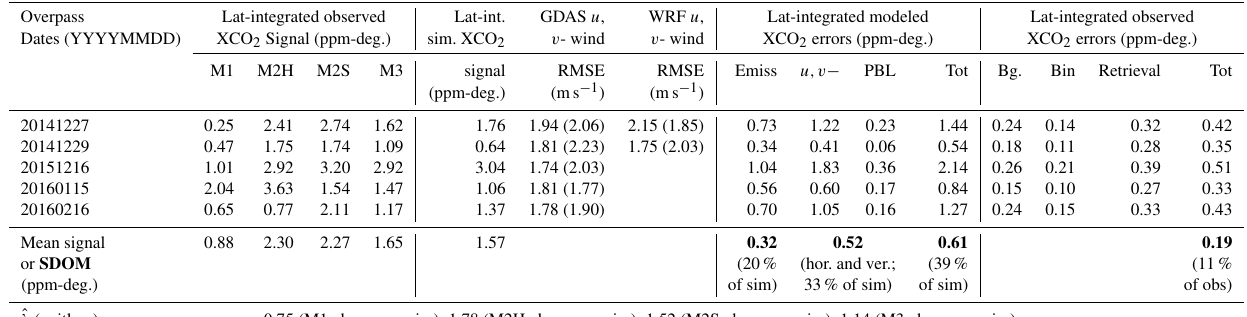
Table 1. Results of signal and error calculations for the five overpasses examined, including latitude-integrated observed versus modeled XCO 2 enhancements and errors (ppm-degree of latitude), regional wind RMSE (ms − 1 ), and the standard deviation of the mean (SDOM) for various errors and posterior scaling factors (unitless) of the mean modeled XCO 2 signal. The GDAS and WRF regional wind speed RMSEs from 0 to 3km or from 3 to 6km are shown within or outside the parentheses, respectively. Overpass Lat-integrated observed Lat-int. GDAS u , WRF u , Lat-integrated modeled Lat-integrated observed Dates (YYYYMMDD) XCO 2 Signal (ppm-deg.) sim. XCO 2 v - wind v - wind XCO 2 errors (ppm-deg.) XCO 2 errors (ppm-deg.) M1 M2H M2S M3 signal RMSE RMSE Emiss u,v − PBL Tot Bg. (ms − 1 ) (ms − 1